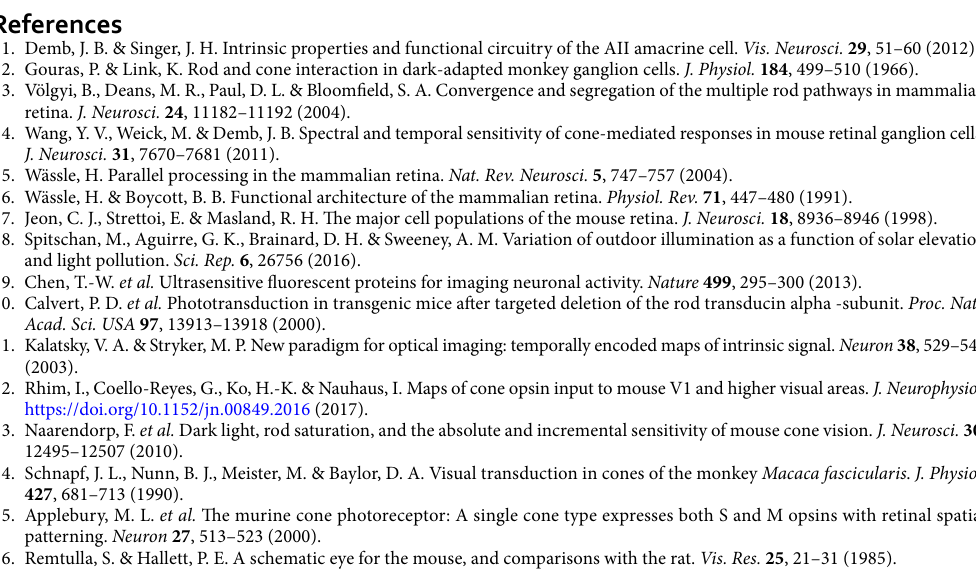
361/818 at 44.13%. Receptive field size mapping (Fig. 7): 108/1082 cells. For the graded light adaptation experi- ments in 11 WTs (Figs. 2, 3), the yield varied slightly across the different states of adaptation, “b1-b6”. In 2 of the 11 animals, b6 was not run. For b6, the yield was 666/1014 cells. For b1-b5 (11 animals), the yield ranged from 773/1252 at b2, up to 791/1252 at b5. The Gnat1 −/− yield was as follows: Temporal frequency experiment (Fig. 5d-f) 244/1218 cells at 20.03%. Spatial frequency experiment (Fig. 6e-h): 72/838 cells at 8.59%. For the graded light adaptation (Fig. 3a,b), the yield ranged from 94/215 at b1, up to 102/215 at b6. Data